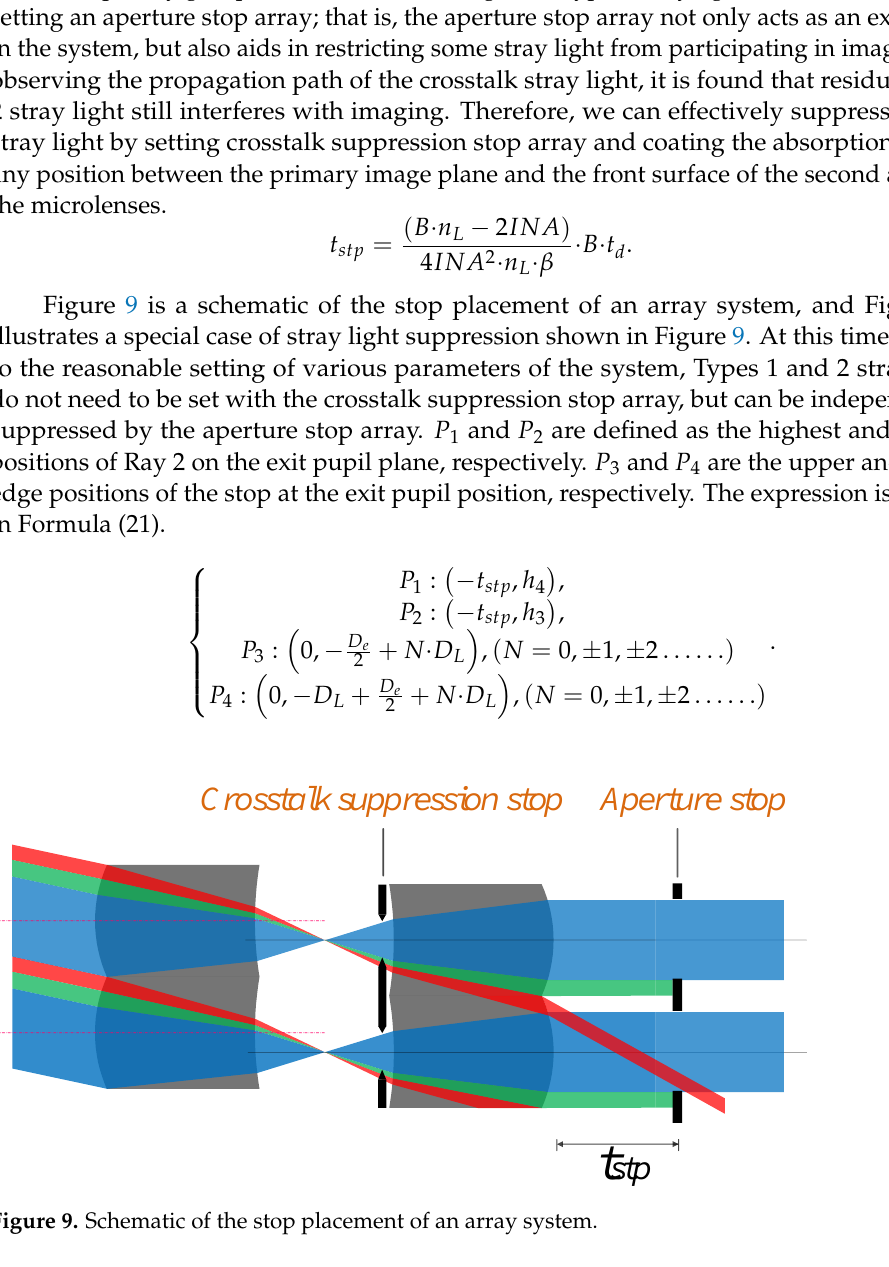
P 3 P 4 Figure 10. Specific schematic of the stray light suppression. {